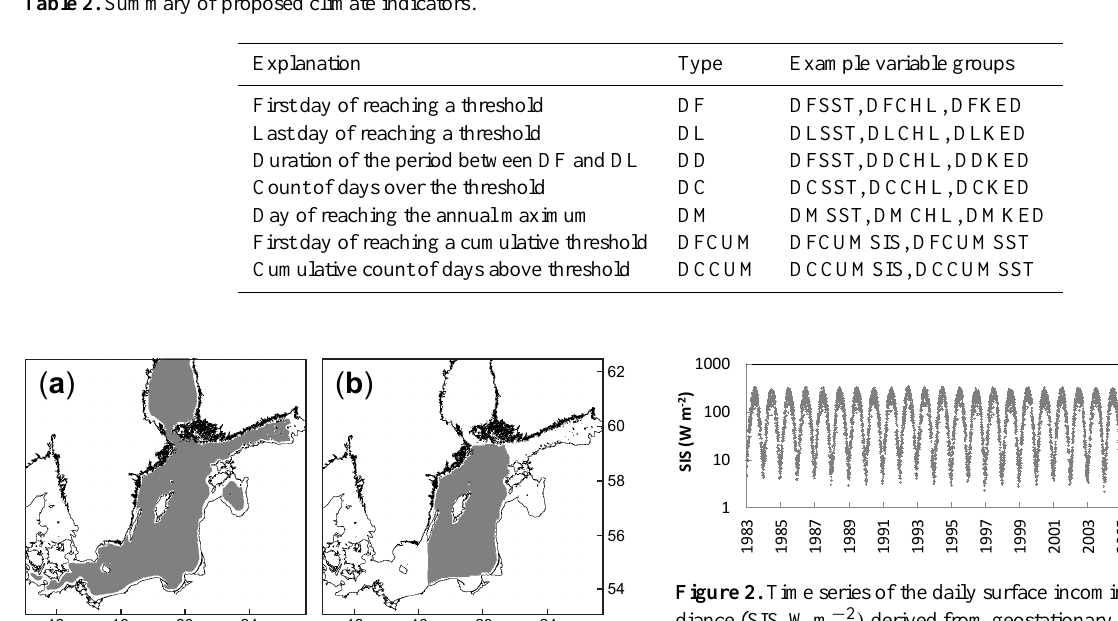
Table 2. Summary of proposed climate indicators.